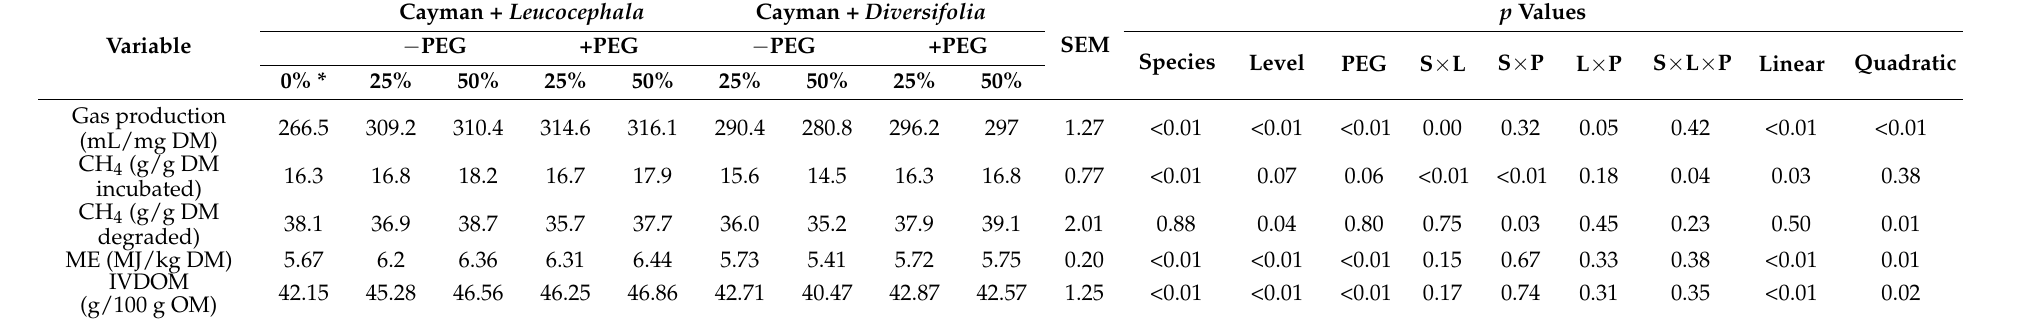
Table 3. Effect of the inclusion of Leucaena on fermentation parameters and methane production of Urochloa hybrid cv Cayman grass-based treatments.